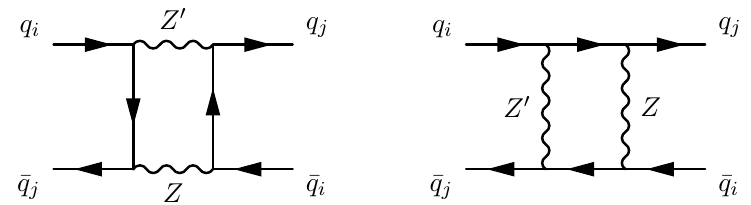
Figure 19 . One-loop mixing diagram giving rise to higher order corrections of the four-quark operators eqs. (3.2){(3.4). The same diagrams exist also with a Higgs boson instead of the additional Z . A third correction comes from the right diagram with the Z exchanged by a second Z 0